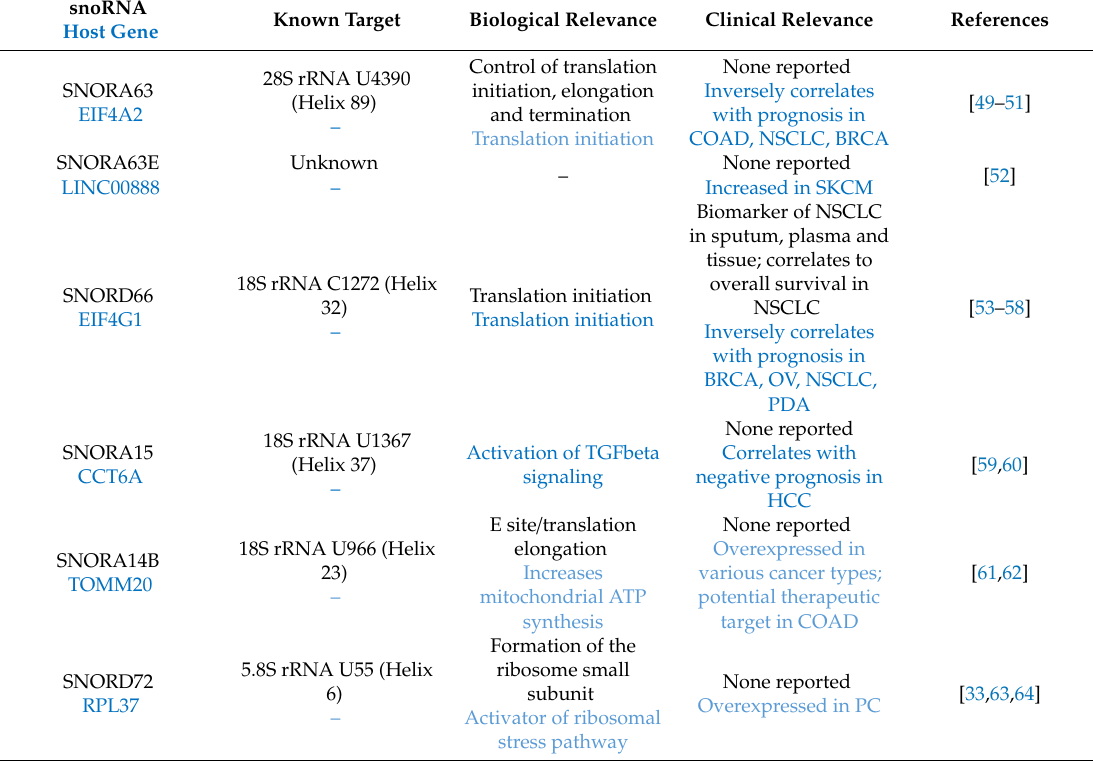
Table 2. Relevance of snoRNA / host gene couples for which CNAs recur more frequently in multiple cancer